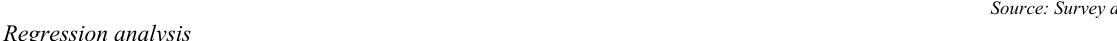
Reliability test of factor “Consumer behavior”